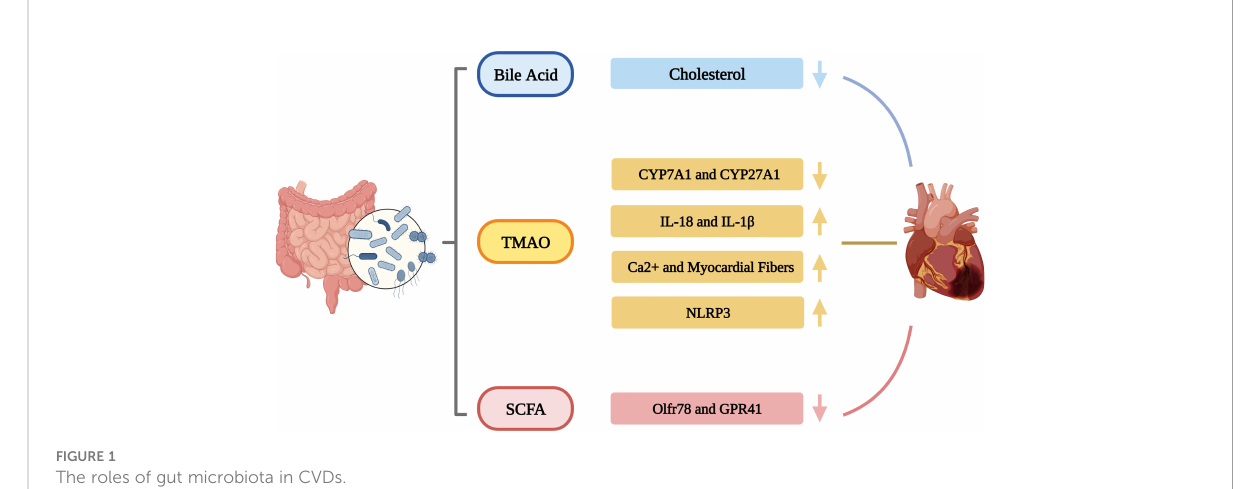
FIGURE 1 The roles of gut microbiota in